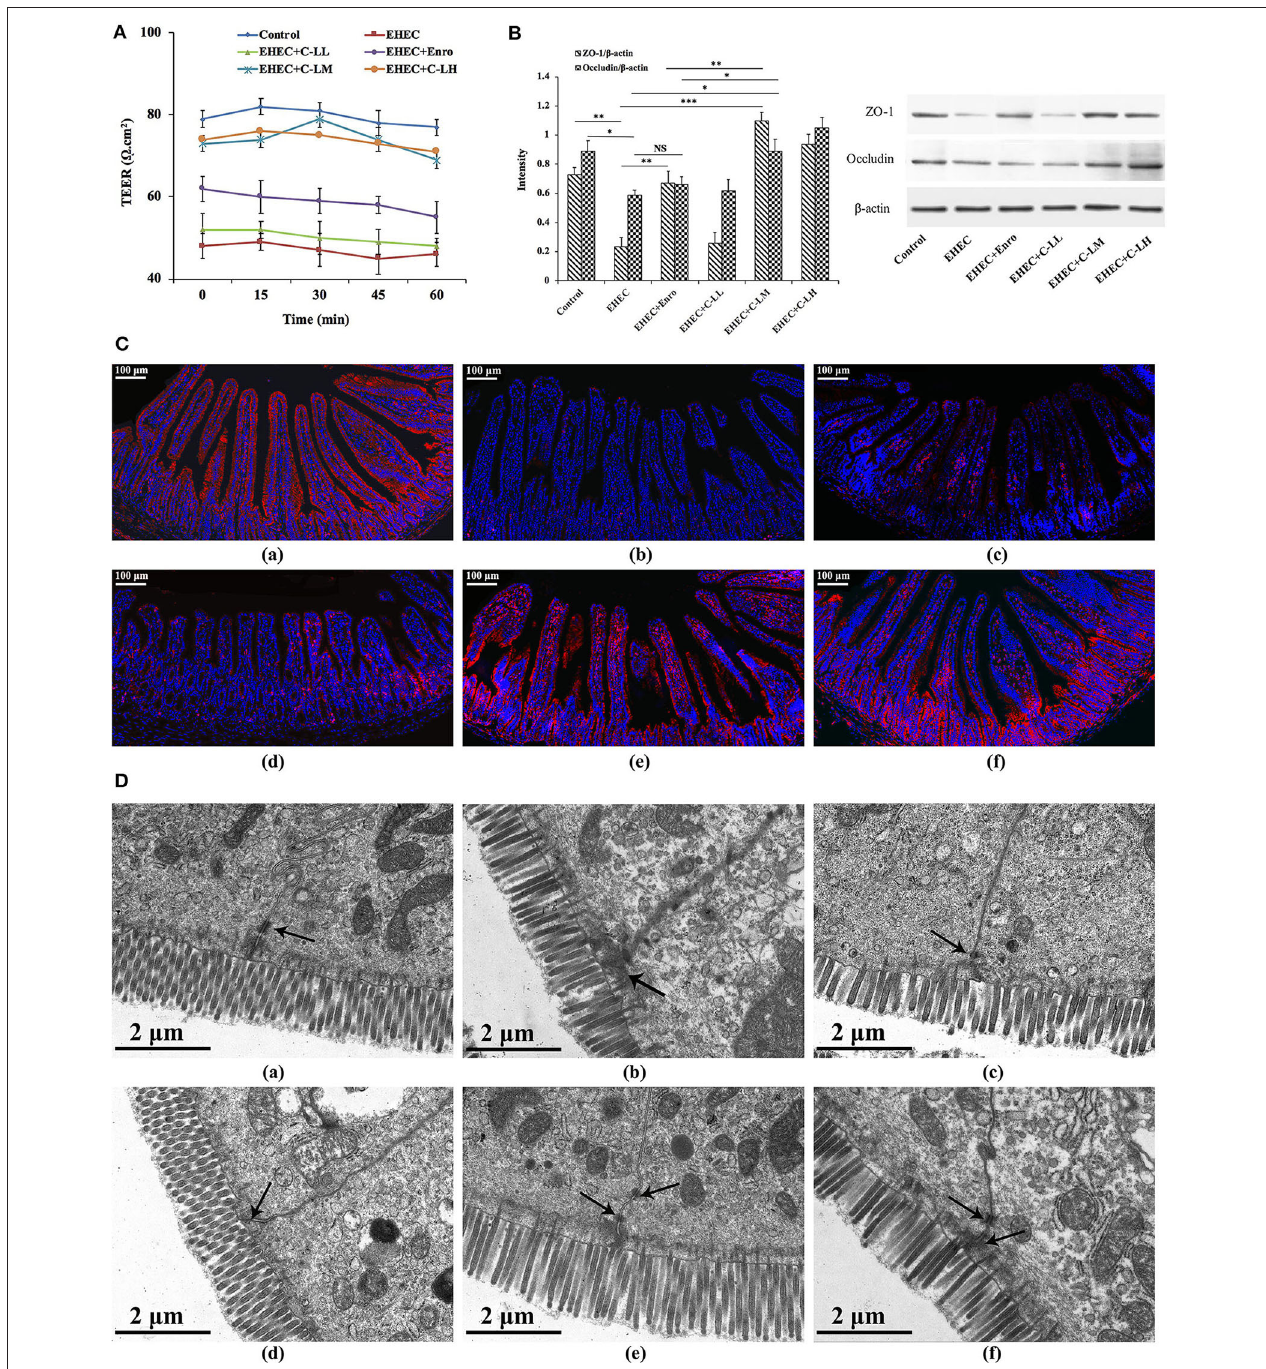
FIGURE 7 | The protective effects of C-L on the intestinal barrier. (A) TEER values in mouse jejunum epithelium were detected using a Ussing chamber. (B) Expression levels of epithelial barrier function-related proteins (occluding and ZO-1) were determined by western blotting. (C) For immunofluorescence staining of occludin (red color) in jejunum tissue, stained slides with the ( C -a) Control, ( C -b) EHEC, ( C -c) EHEC + Enro, ( C -d) EHEC + C-LL, ( C -e) EHEC + C-LM, ( C -f) EHEC + C-LH groups were observed under a fluorescence microscope. Scale bar, 100 µ m. (D) The protective effects of C-L on intestinal tight junction structures were examined by TEM for the ( D -a) Control, ( D -b) EHEC, ( D -c) EHEC + Enro, ( D -d) EHEC + C-LL, ( D -e) EHEC + C-LM, ( D -f) EHEC + C-LH groups. Narrower intervals and clearer desmosomes (black arrows) between the intestinal epithelial cells were found in C-L-treated mice. Scale bar, 2 µ m. The control group was orally administered 100 µ L sterile PBS; the EHEC group was orally administered 100 µ L sterile PBS containing 1 × 10 8 CFUs EHEC O157:H7; the EHEC + Enro group was orally administered 100 µ L sterile PBS containing 1 × 10 8 CFUs EHEC O157:H7 and then treated by i.p. injection with 8 mg/kg Enro once/day for 3 days; the EHEC + C-LL, EHEC + C-LM, and EHEC + C-LH groups were administered 100 µ L sterile PBS containing 1 × 10 8 CFUs EHEC O157:H7 and then treated by i.p. injection with 4, 8, and 16 mg/kg C-L, respectively, once/day for 3 days. The data are shown as the mean ± standard deviation ( n = 5). NS, P > 0.05; * P ≤ 0.05; ** P ≤ 0.01; *** P ≤ 0.001.